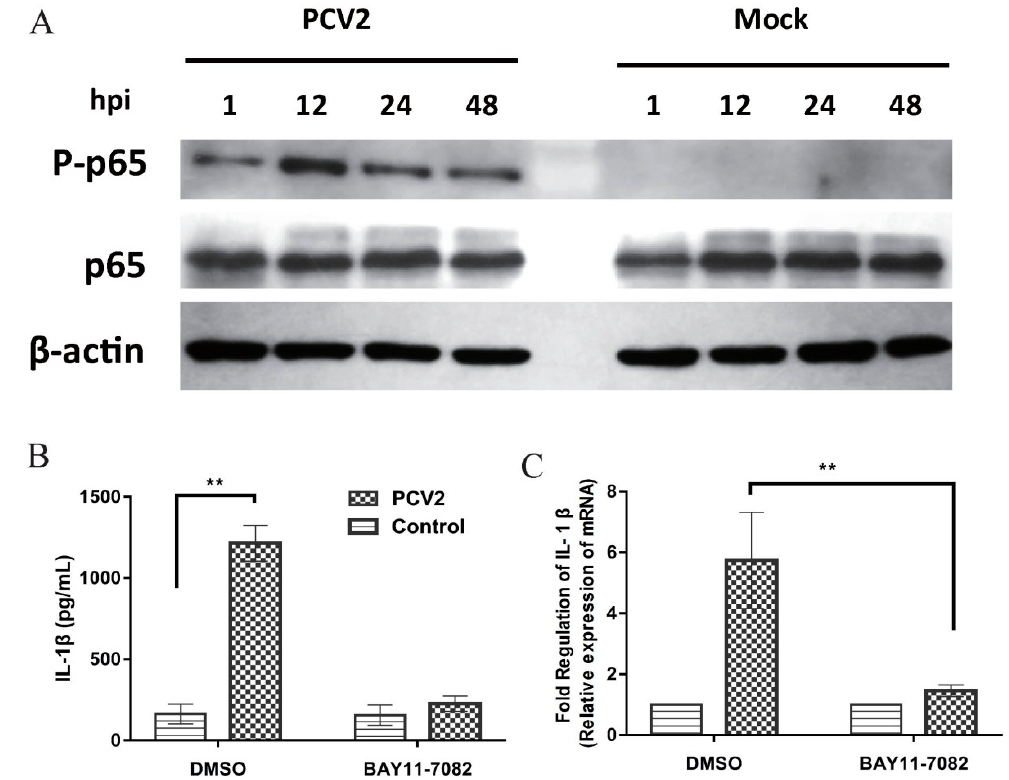
Figure 5. NF- κ B activation is critical for PCV2-induced IL-1 β production in PAMs. PAMs were infected with PCV2 at an MOI of 1 for 1, 12, 24, and 48 h, and the p-p65 and p65 expression were measured by Western blotting ( A ). PAMs were treated with DMSO, BAY11-7082 (1 µ M) for 1 h then infected with PCV2 at an MOI of 1. The supernatants were collected at 12 hpi and analyzed for IL-1 β by ELISA ( B ). Total cells were harvested and analyzed for IL-1 β mRNA expression by real-time RT-PCR ( C ). DMSO, the solubilization bu ff er of BAY11-7082, was used as a control. Results are mean ± SE of three independent experiments. ** represent p < 0.01.